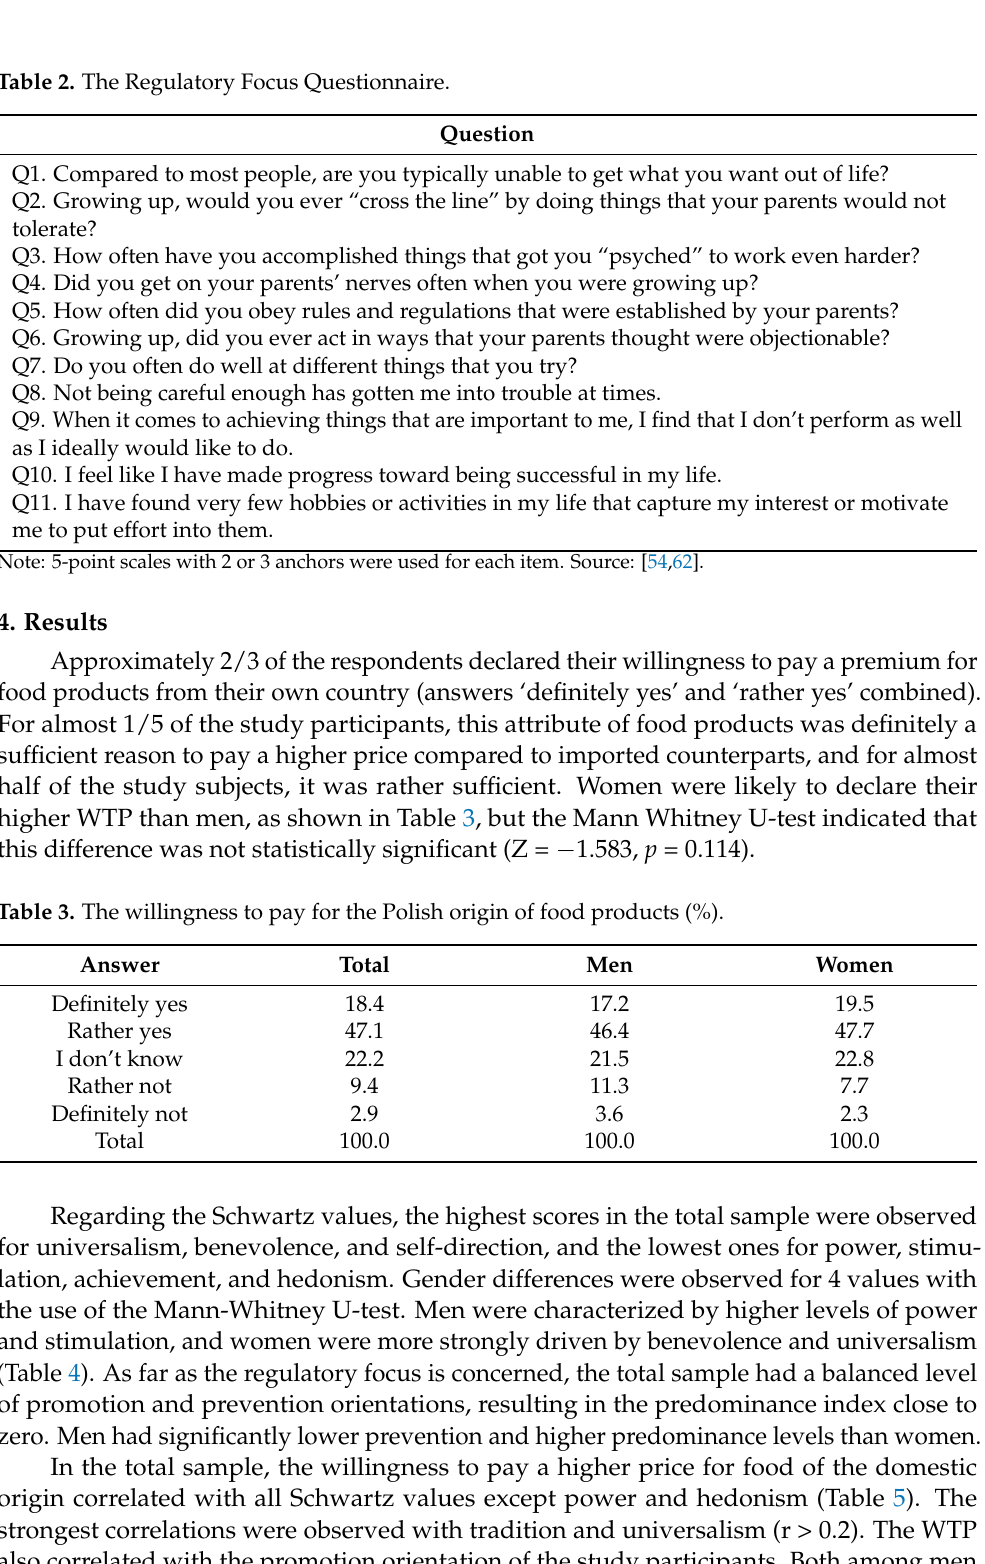
Table 2. The Regulatory Focus Questionnaire.